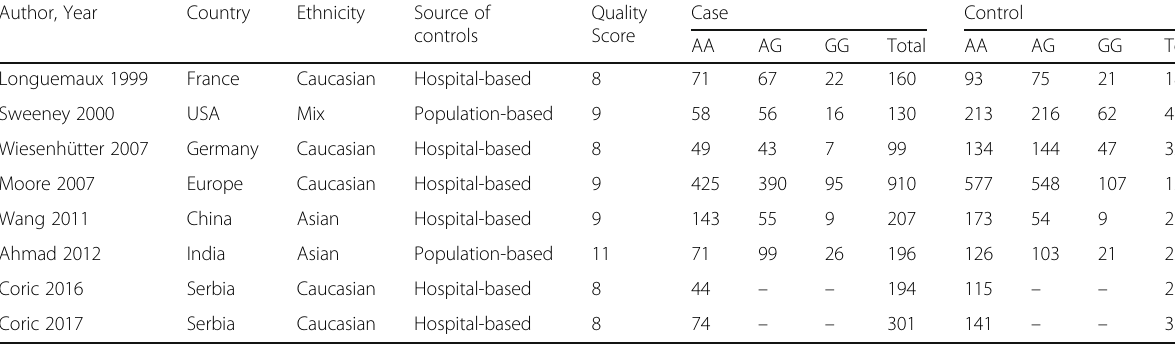
Table 2 Characteristics of studies evaluating the effects of GSTP1 gene polymorphism on RCC risk Author, Year Country Ethnicity Source of